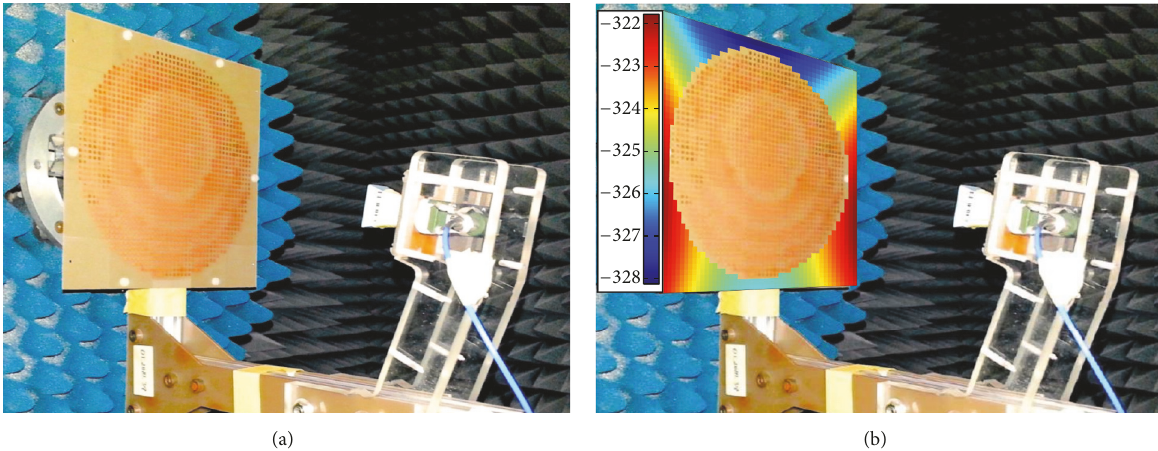
Figure 10: Picture of the reflectarray prototype which generates an isoflux pattern for global Earth coverage. (a) Original photograph. (b) In the picture it is shown as being superimposed on the frame the phase distribution (in degrees) simulated for the dielectric frame for 𝑋 polarization.